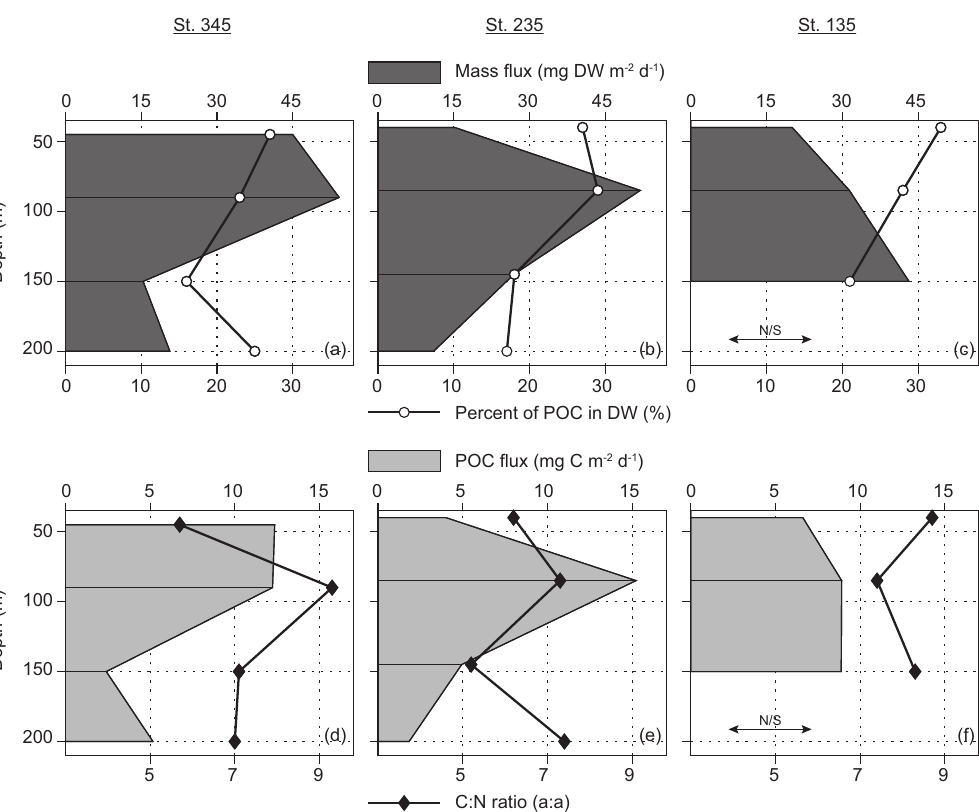
Fig. 7. Vertical profiles of daily vertical mass fluxes (dry weight, DW), percentage of POC in DW, particulate organic carbon fluxes (POC), and C:N ratios, recorded with short-term drifting traps deployed at stations 345 (a, d) , 235 (b, e) , and 135 (c, f) , during the Malina 2009 campaign. The location of the short-term traps is given in Fig. 1 and details of the deployments in Table 1. N/S: no sampling.